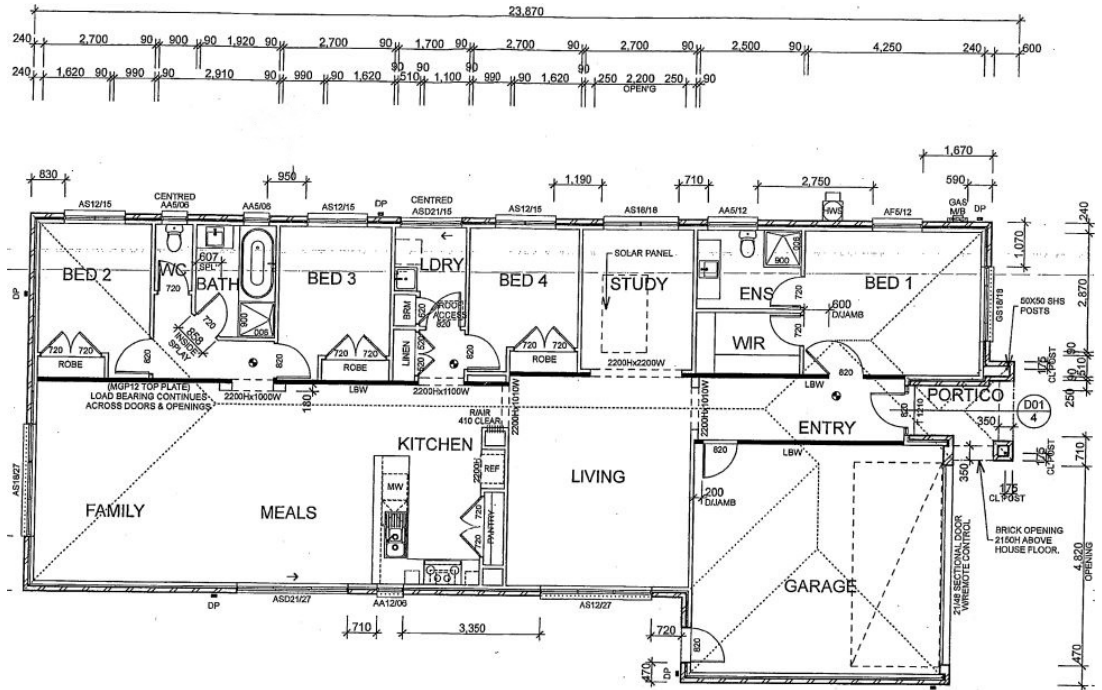
Figure 2. Floor Plan of the case study house.